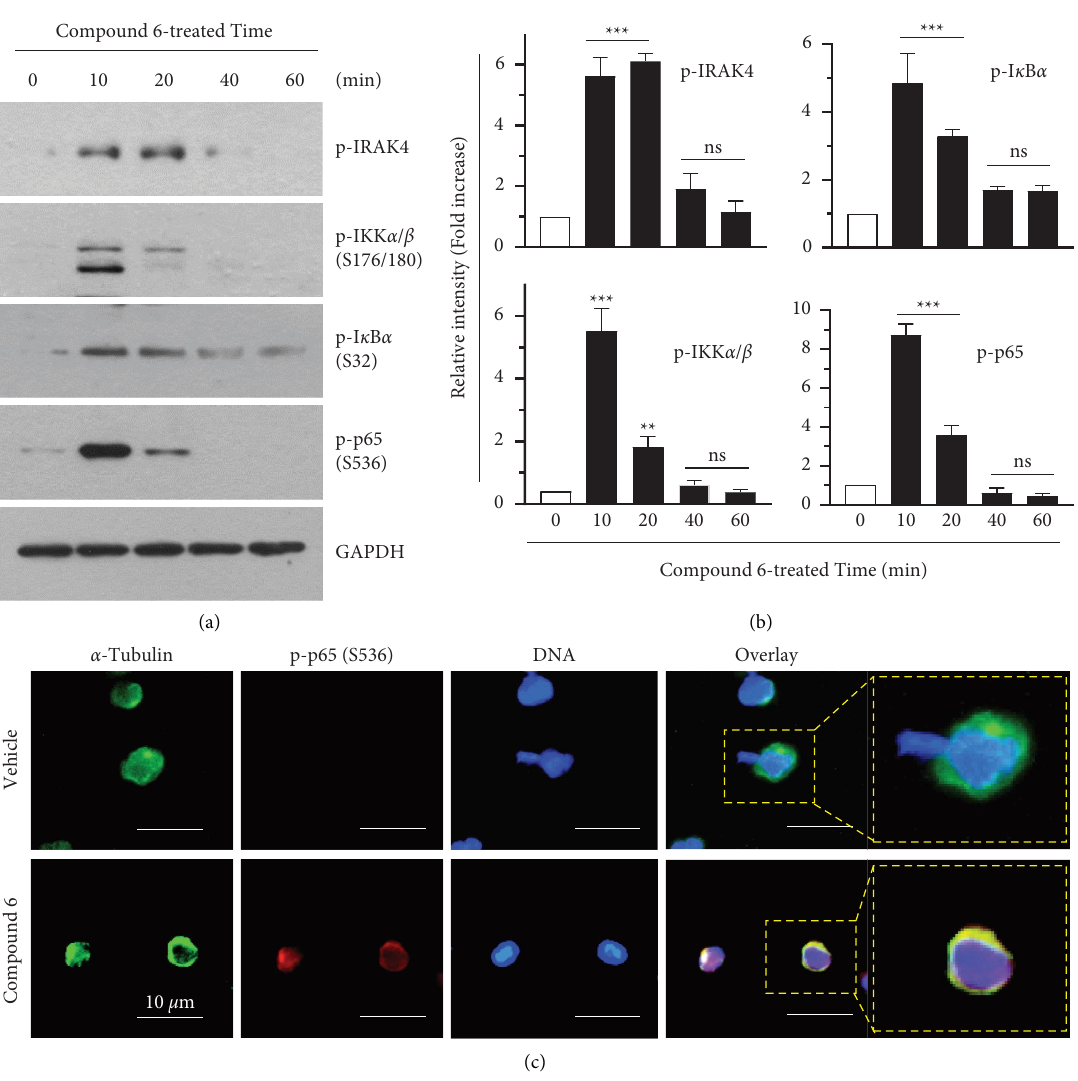
Figure 4: TLR7 agonist activity of compound 6 . (a) Images of SEAP assay plates. THP1 cells were treated with 40 μ M compound 6 for diferent durations. Whole-cell lysates were immunoblotted with antibodies against phospho-IRAK4 (Tr345/Ser346), − IKK α /B (Ser176/ 180), − I κ B α (Ser32), and -p65/RelA NF- κ B (Ser536). GAPDH level was used as an internal control. (b) Protein band intensities